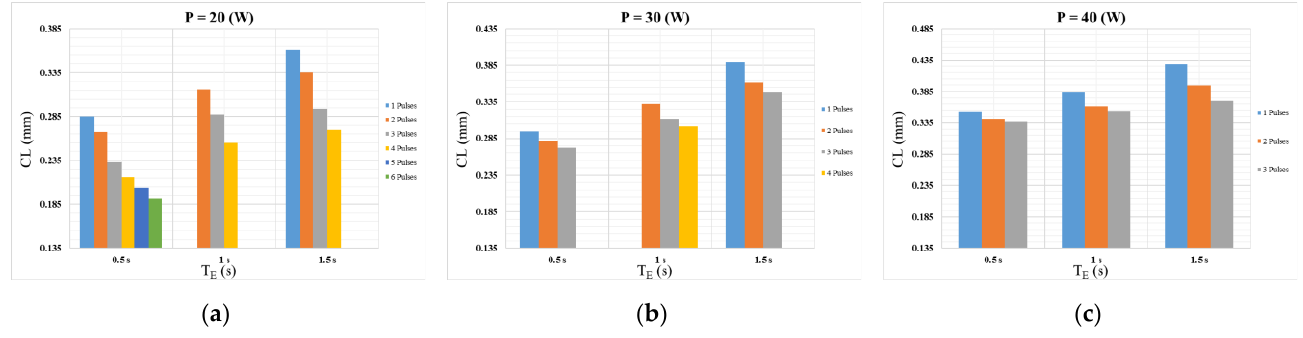
Figure 5. Influence of T E and N P on CL for 0.05 wt.% of CNPs and ( a ) P = 20 W, ( b ) P = 30 W and ( c ) P = 40 W.